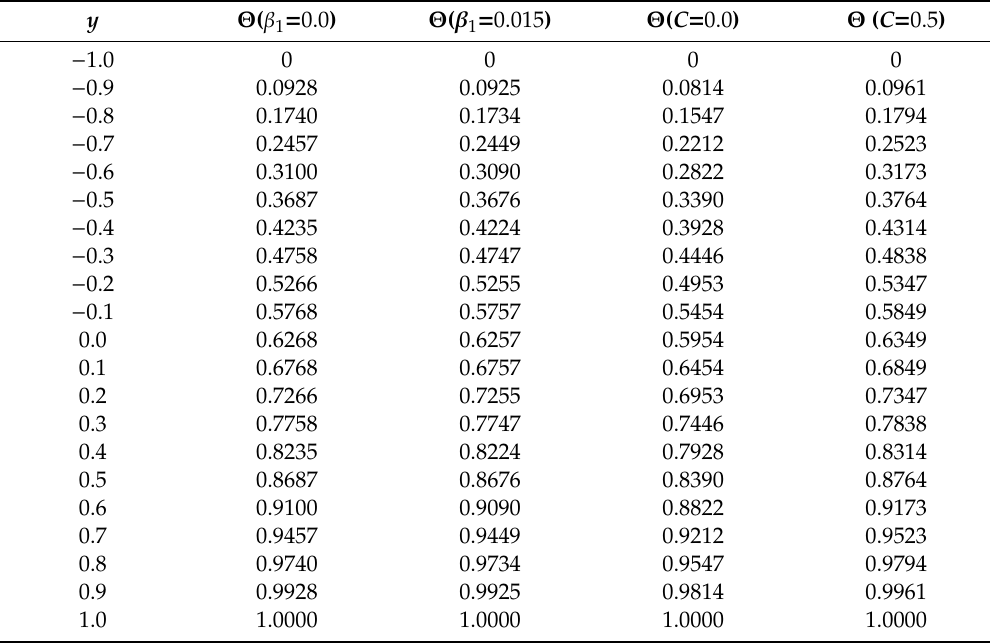
Table 3. Thermal variation at the di ff erent points of given